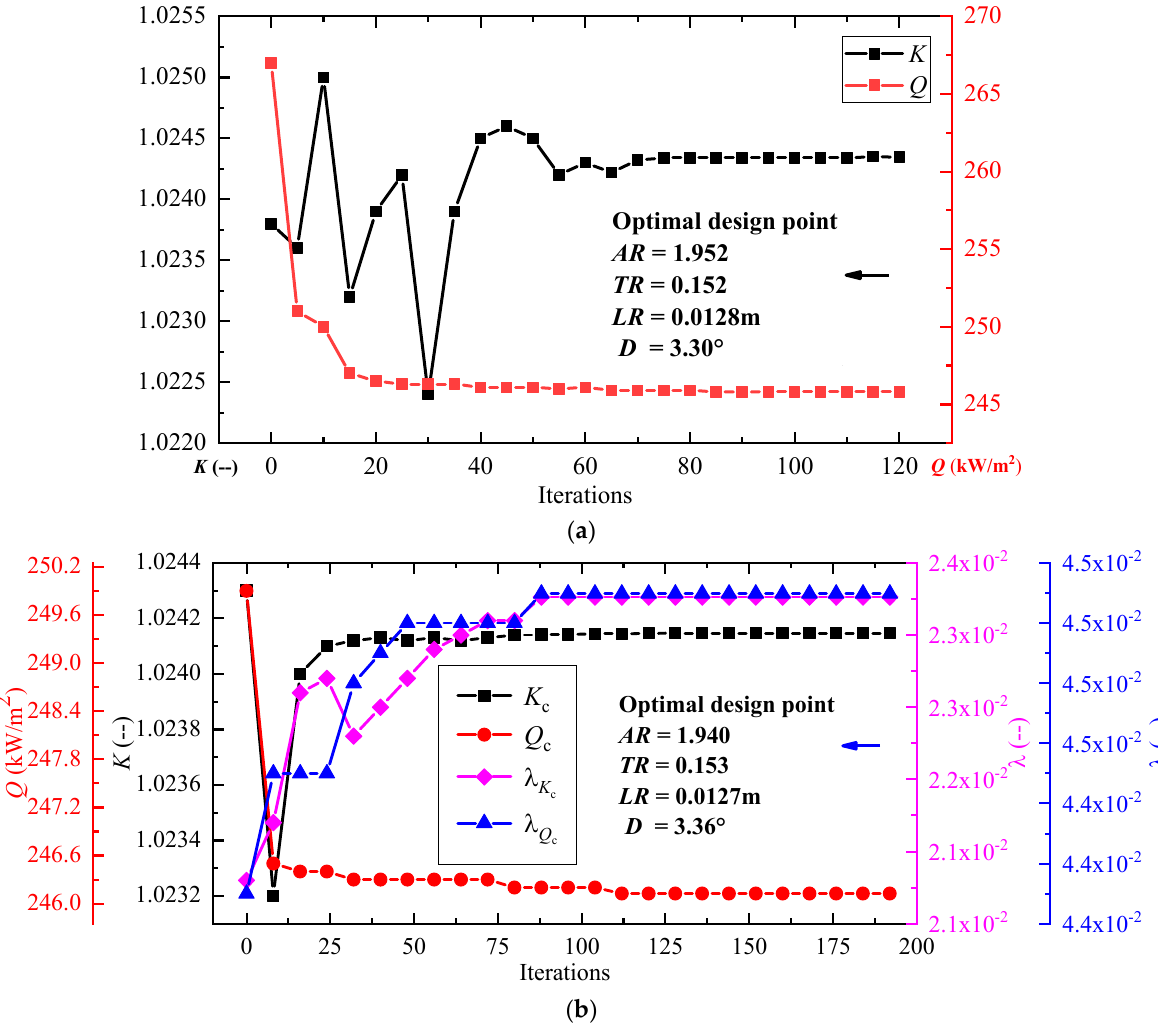
Figure 6. Illustration of the optimization processes. ( a ) Traditional DOD; ( b ) ROD. Table 3. Comparisons of the three aerodynamic shapes for the hypersonic wing.